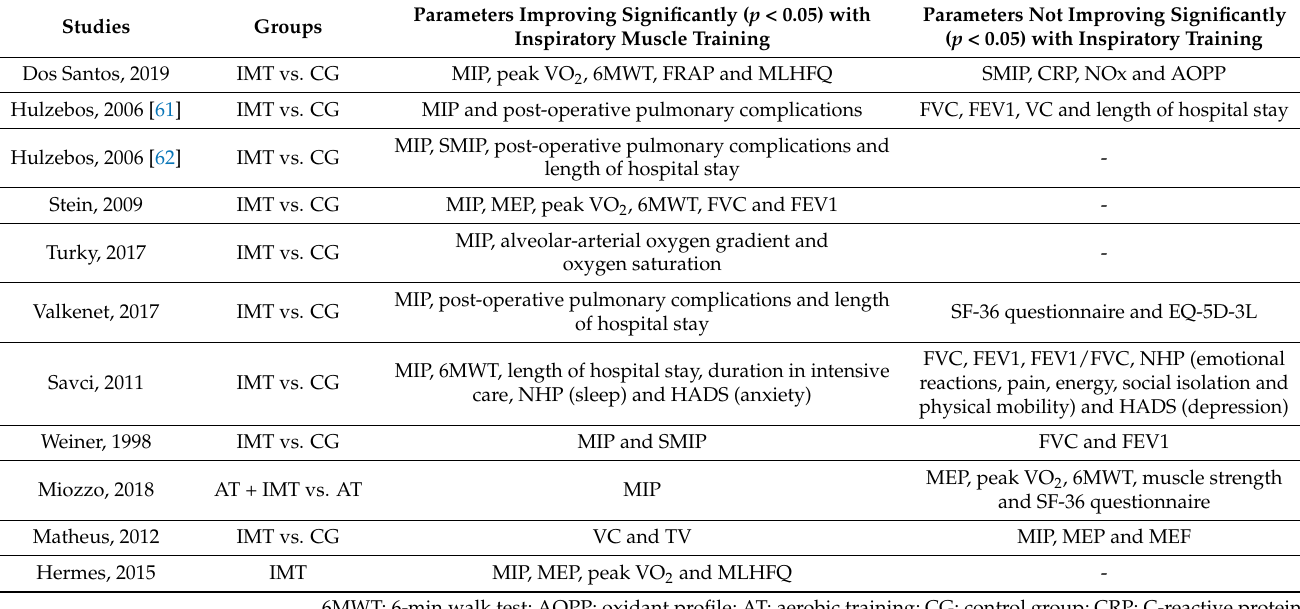
Table 3. Effects of inspiratory muscle training in patients with coronary artery